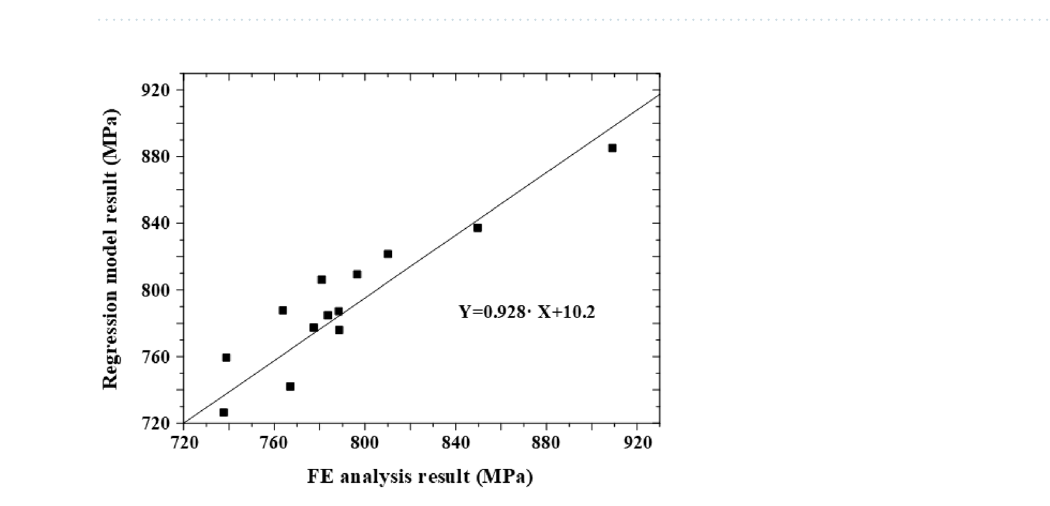
Figure 26. Comparison of the results of FE analysis and the regression model for predicting equivalent bending